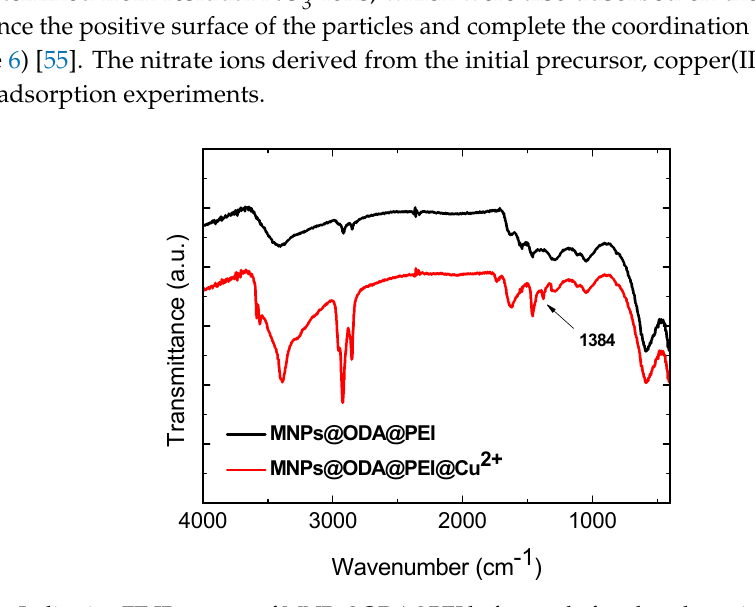
Figure 6. Indicative FT-IR spectra of MNPs@ODA@PEI before and after the adsorption of copper ions.